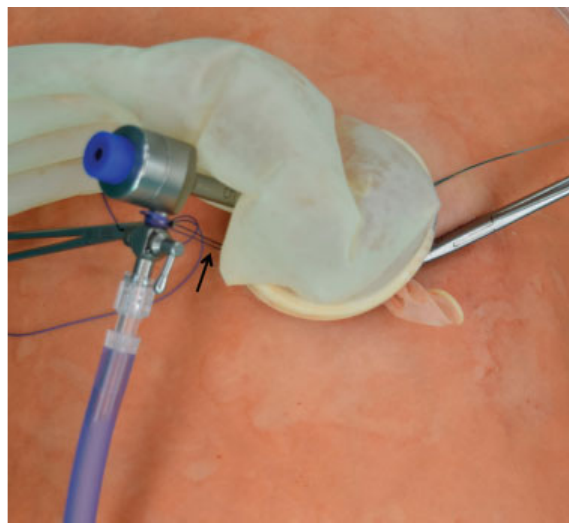
Fig. 3 The fi xation of 5-mm trocar between the trocar valve and the